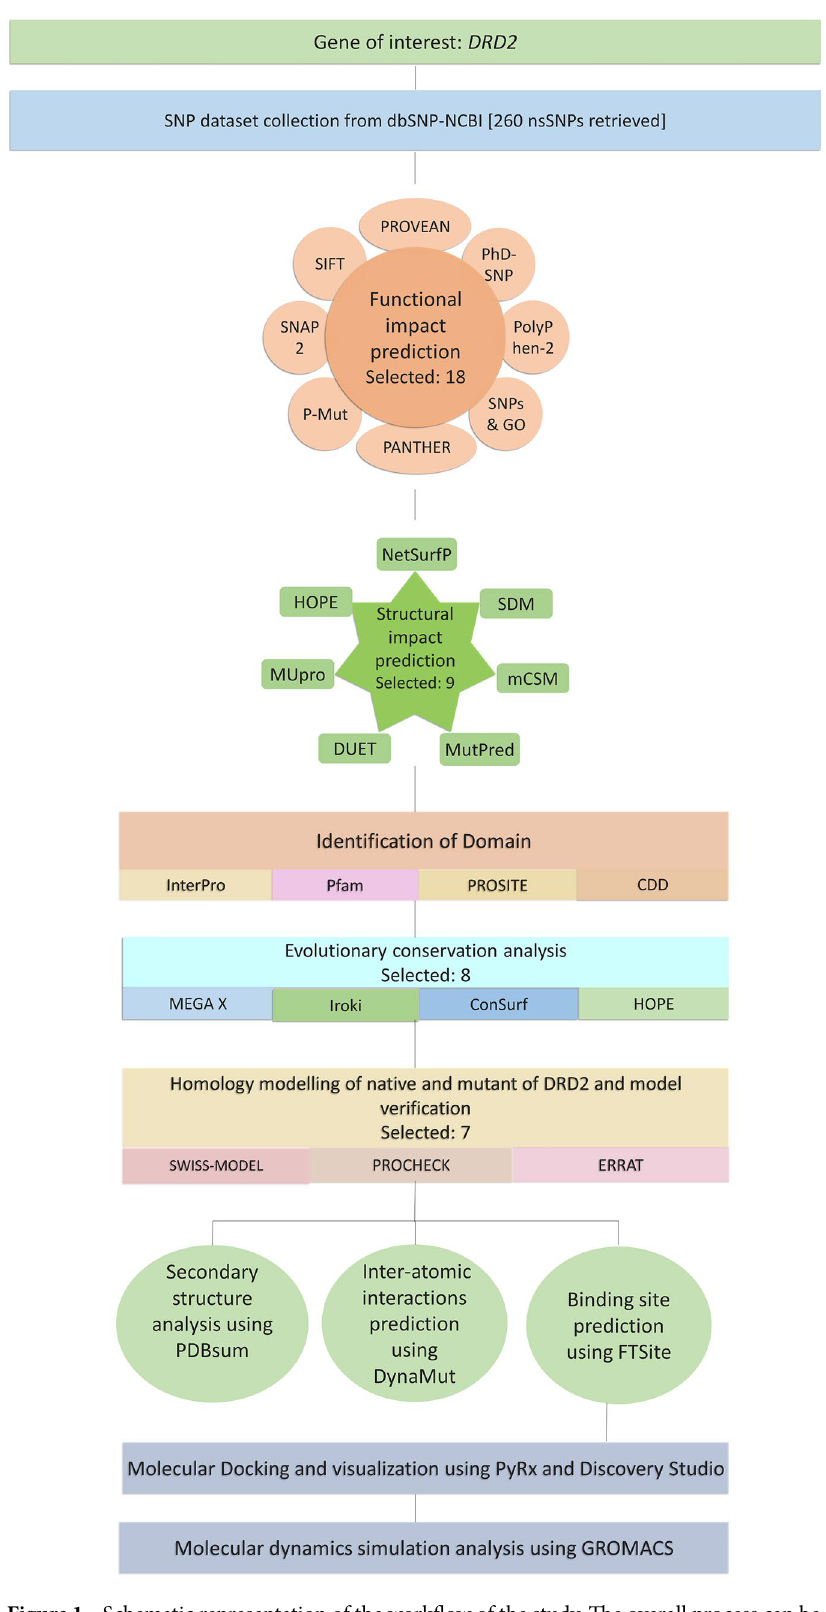
Figure 1. Schematic representation of the workflow of the study. The overall process can be summarized as a series of progressive filtration steps pursued for the identification of the most damaging nsSNPs of Drd2 and subsequent in-depth analysis of one particular